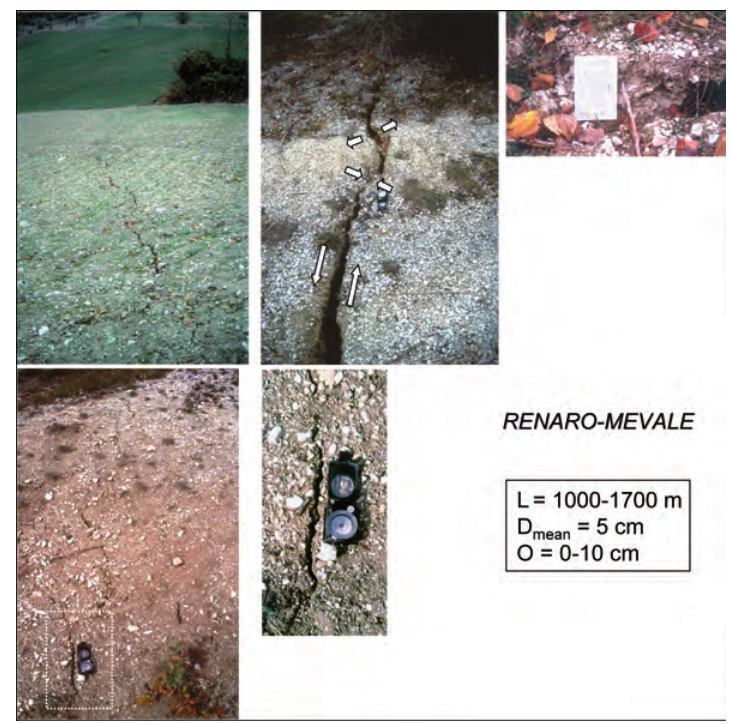
Fig. 8. Fractures south of the Renaro village affecting both recent colluvium/alluvium deposits and bedrock. Maximum horizontal offset of ~5 cm is measured by a dirt road (photo in upper middle); arrows illustrate the sense of slip on fractures. Upper right: detail of open fracture with vertical displacement (maximum value of 15 cm), northeast side up (photos by F.R. Cinti and F. Marra). Frequent right stepping en-echelon geometry of the fractures was observed on the hill top near Ginepro Mt. (lower photos; white box is the detail to the right; pho- tos by F. Marra). Symbols: L = Length, D mean = Vertical Displacement; O =